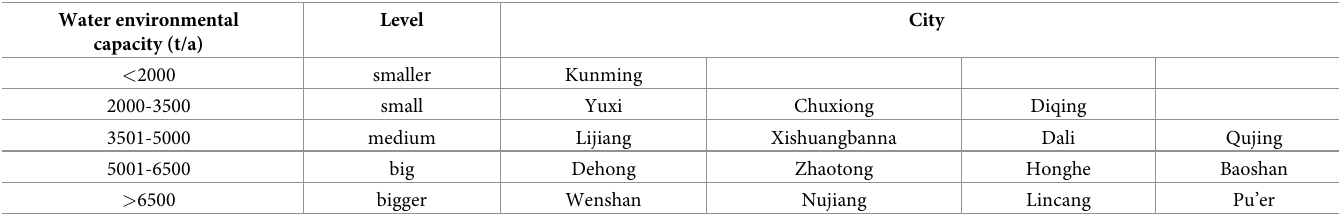
Table 1. Classification of the water environmental capacity in Yunnan Province. Water environmental capacity